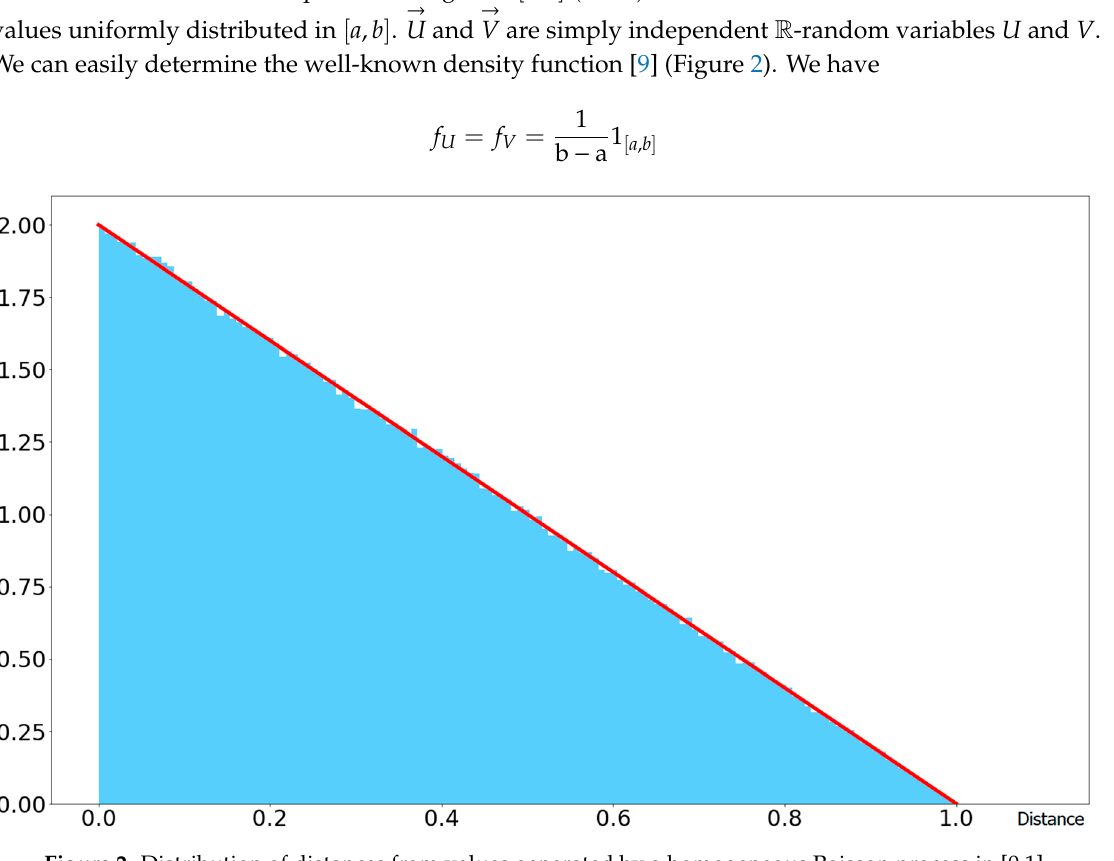
Figure 2. Distribution of distances from values generated by a homogeneous Poisson process in [0,1] with density ρ = 1500. In blue is the distribution of observed distances and in red is the theorical distribution f D ( t ) = 2 ( 1 − t ) in